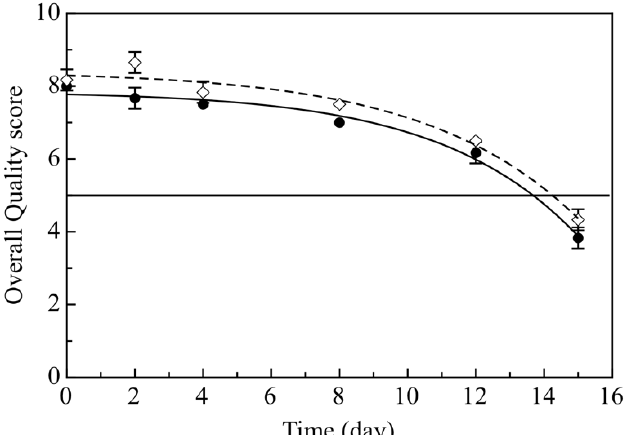
Figure 4. Overall Quality evolution during 15 days of storage of breaded cod sticks. The curves are the best fitting of the experimental data. ( • ) Control breaded cod sticks without olive paste (Ctrl) ( ♦ ) Active breaded cod sticks with olive paste (Active).